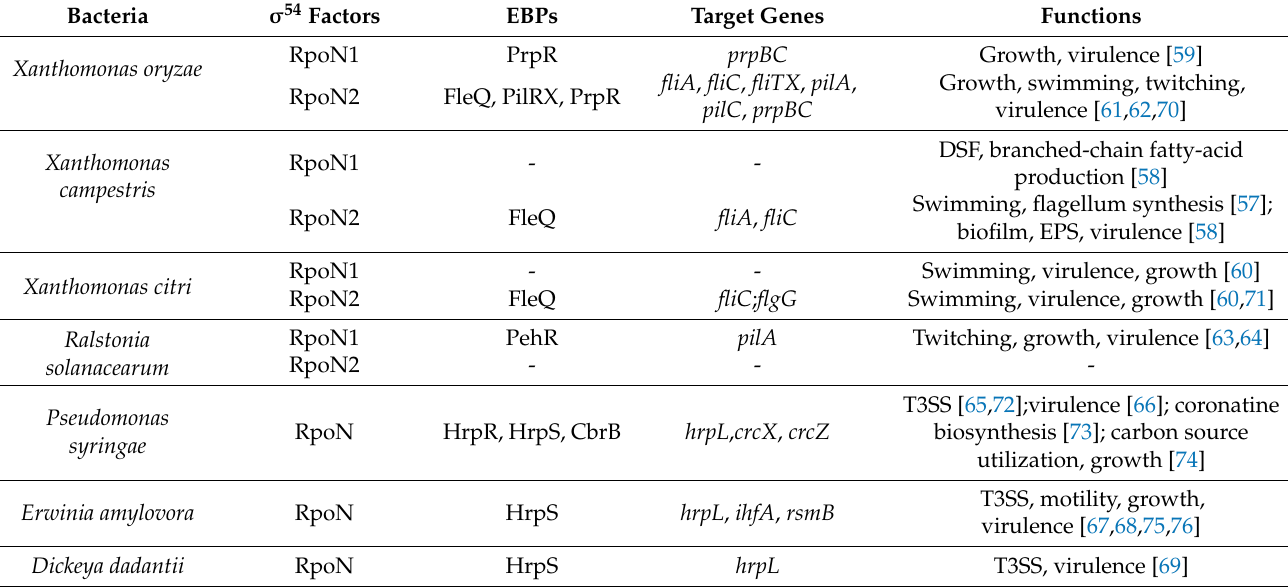
Table 1. The RpoNs and EBPs in major phytopathogenic bacteria.